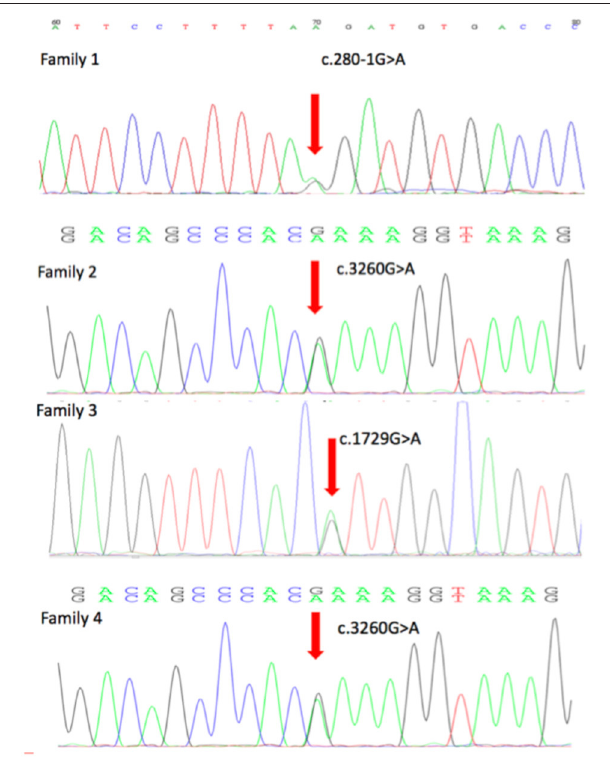
FIGURE 2 | DEPDC5 mutations in the four focal epilepsy families. DNA sequencing chromatograms showed the mutations in DEPDC5 identified in these four families. Red arrows point to the positions of DEPDC5